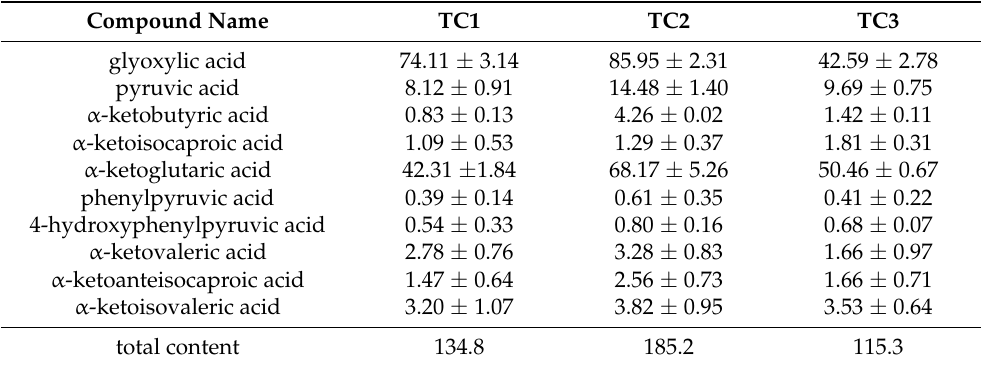
Table 2. Contents of the most relevant α -keto acids in commercial samples TC1–TC3. Results are given in mg/kg dried plant material.